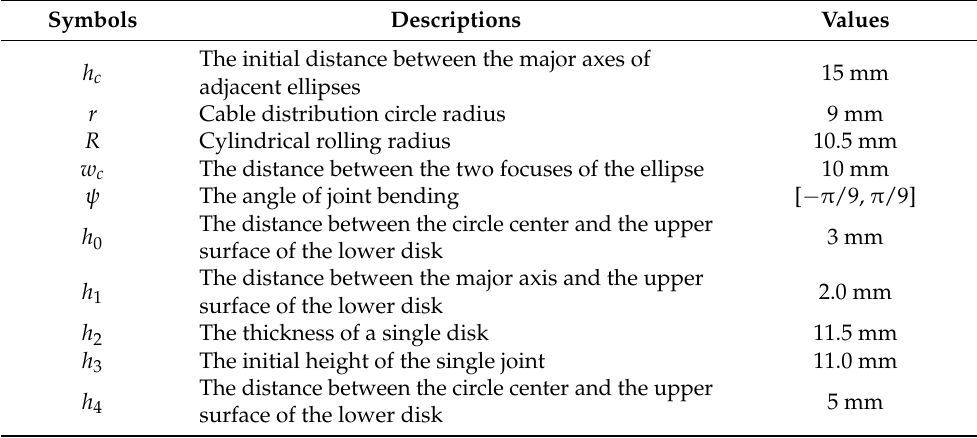
15 mm 3 mm 2.0 mm 5